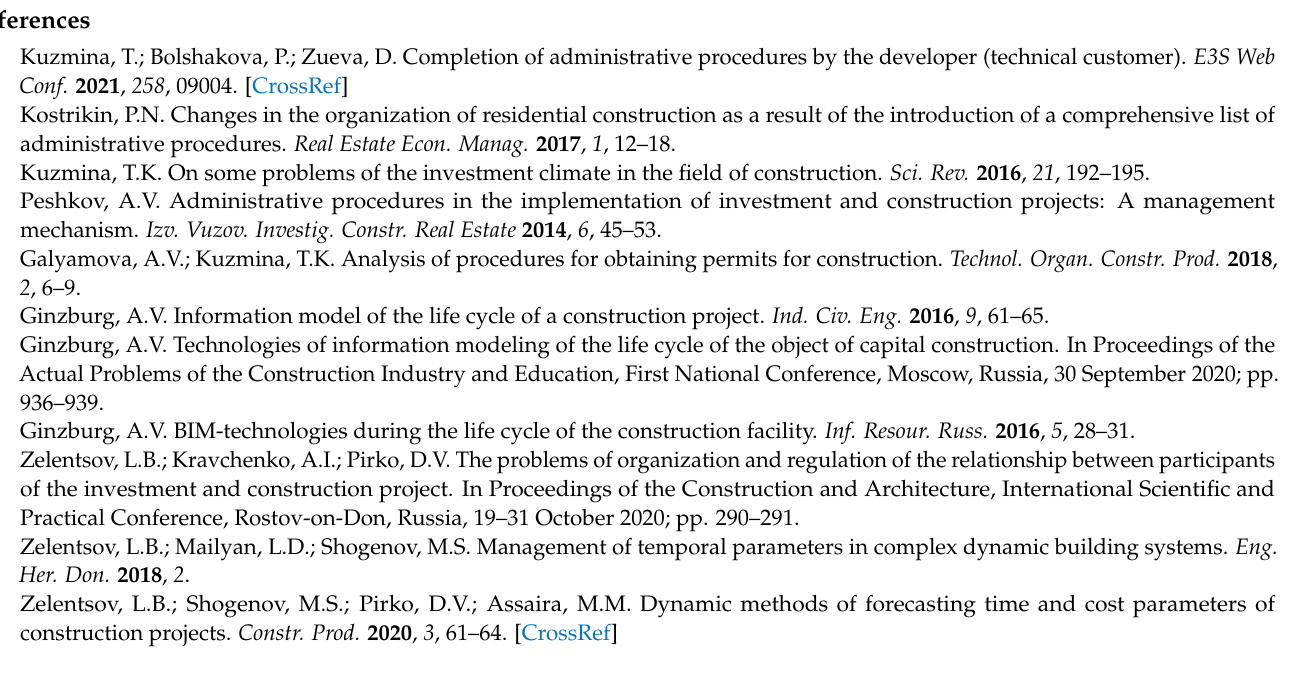
Figure A2. Organizational and management model of procedures based on the minimum values of the duration of stages of pre-project preparation and design development (a combination of factors).